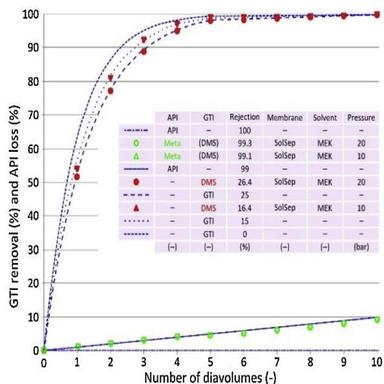
Effect of pressure and number of diavolumes on API/GTI separation.